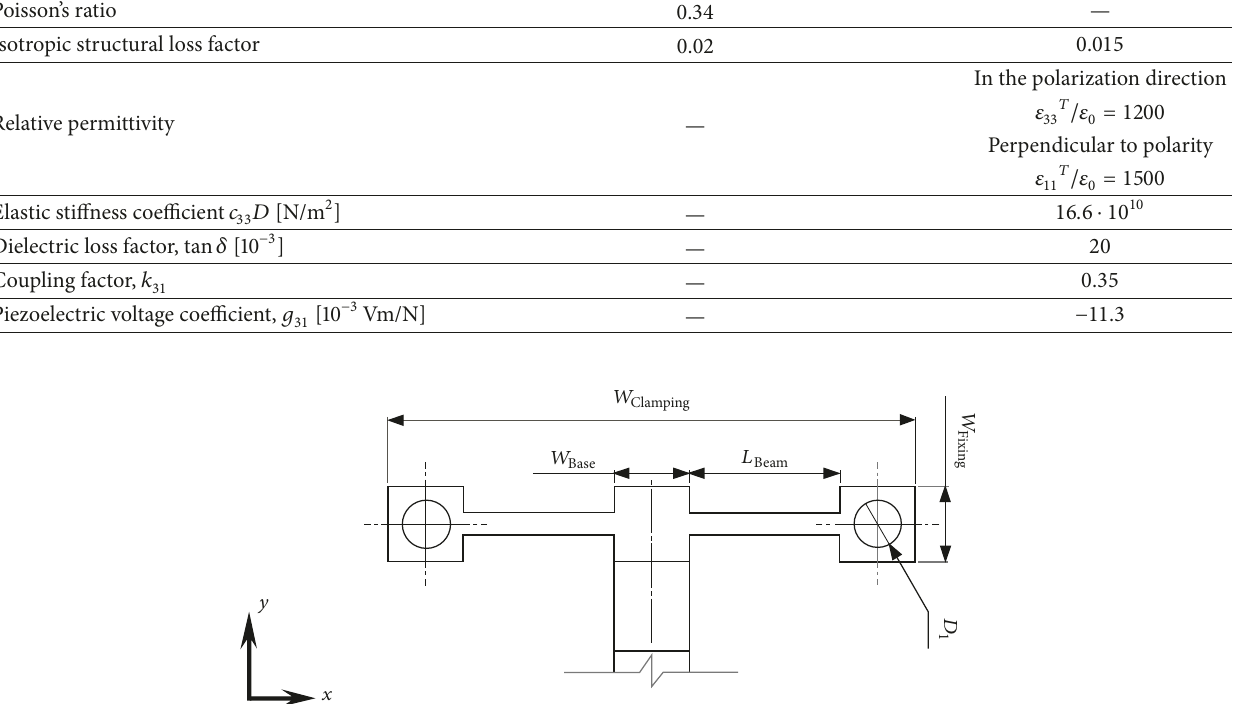
Figure 2: Scheme of the clamping system: 𝑊